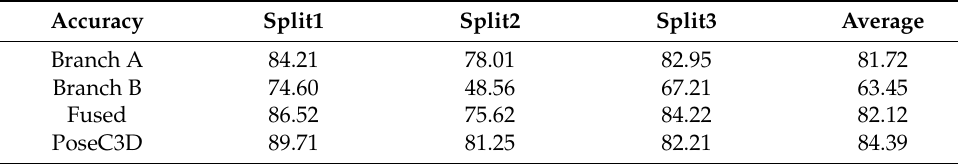
Table 7. Evaluation (accuracy, %) on CCTV the dataset—3